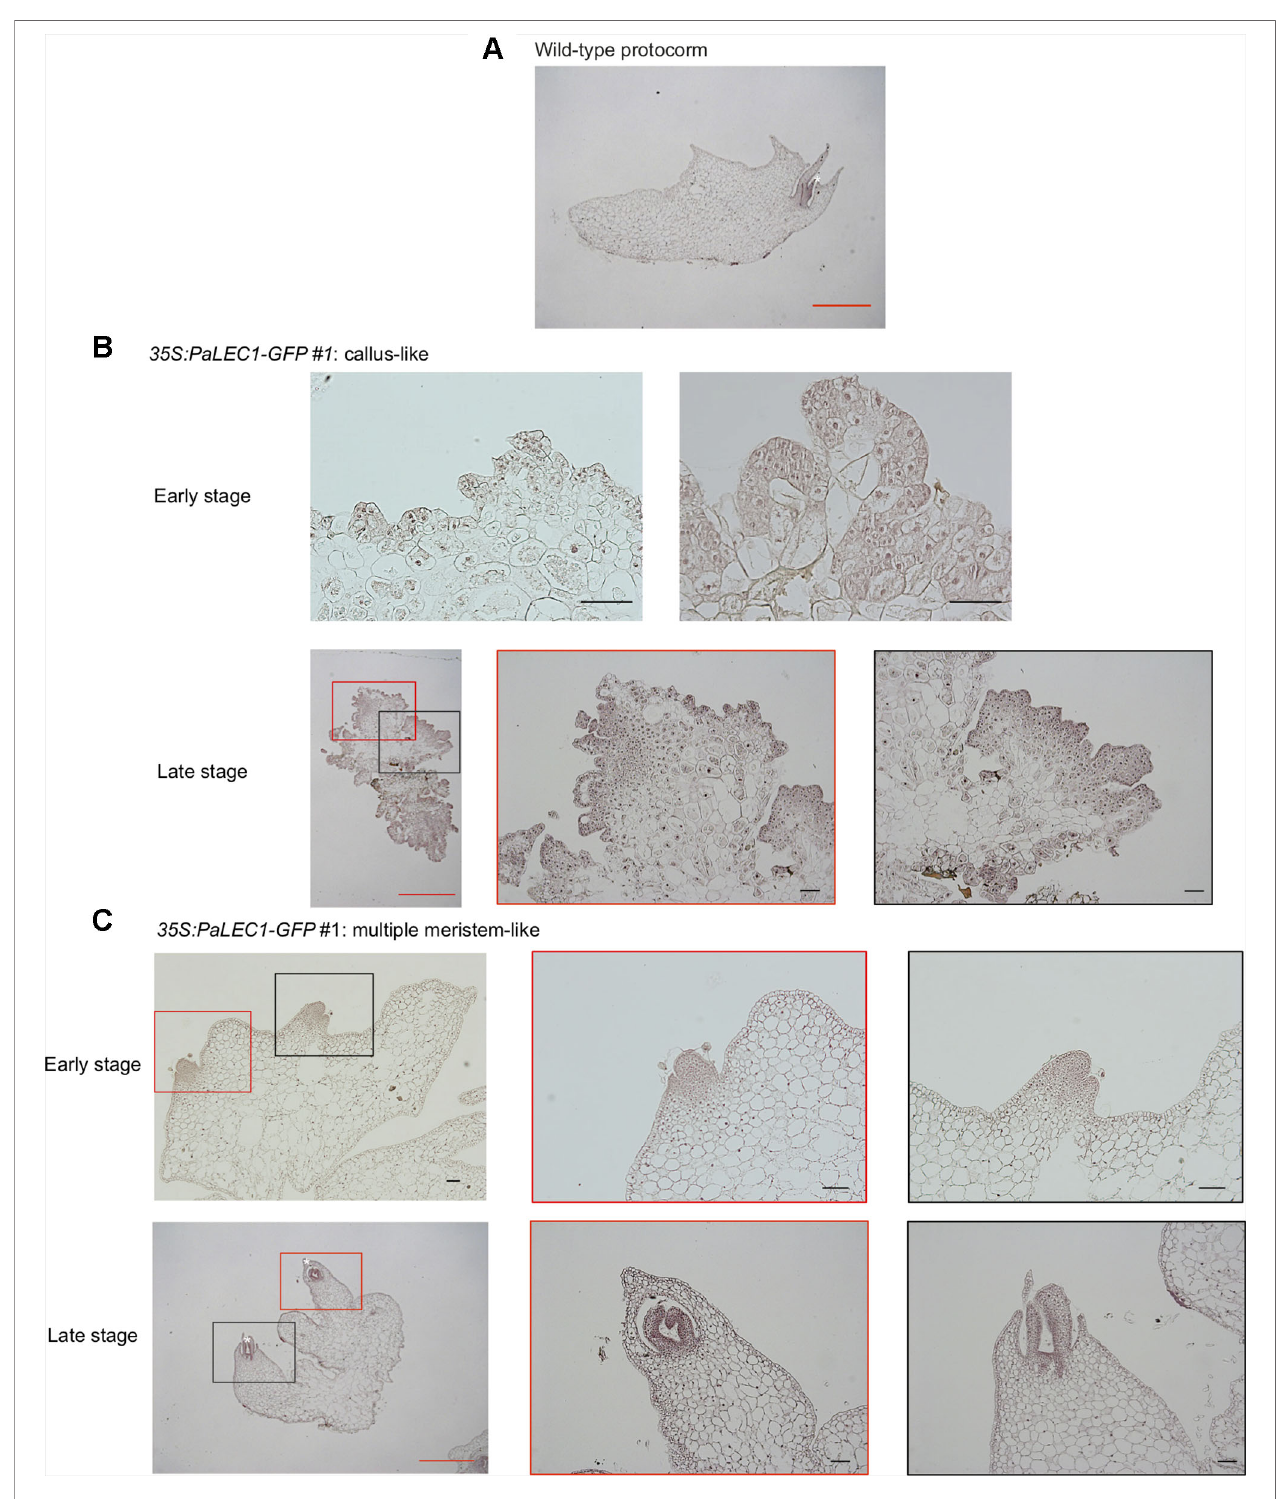
FIGURE 4 | Histological examination of embryonic tissues of 35:PaLEC1-GFP#1 transgenic plants. (A) Light micrograph of 10 m m longitudinal section of developing wild-type protocorm stained with hematoxylin. (B) Light micrograph of a 10 m m section of the early and late stages of callus-like tissues derived from protocorms of the T1 35:PaLEC1-GFP#1 seeds. (C) Light micrograph of a 10 m m section of the early and late stages of multiple meristem-like tissues derived from protocorms of the T1 35:PaLEC1-GFP#1 seeds. Shoot apical meristem (SAM) with the emerging leaf primordia are marked by a white asterisk. For panel (B and C) , low and high magni fi cation of structures marked with red and black rectangles are shown. Red scale bar = 1 mm. Black scale bar = 100 m m.